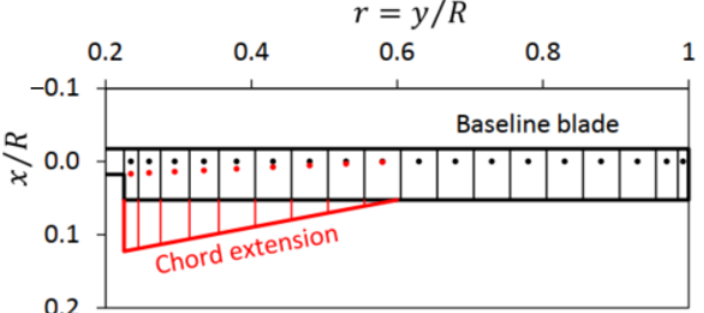
Figure 1. Basic principal of chord extension as a first approximation of a parabolic chord distribution (from [14]).